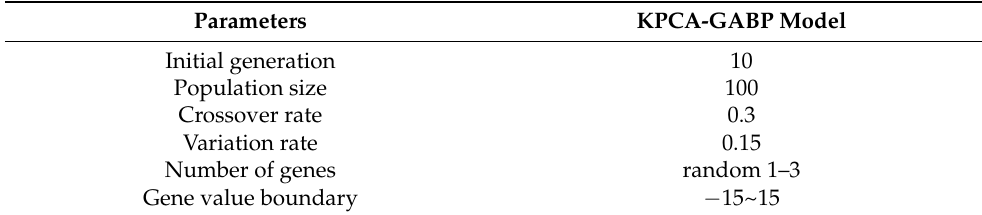
Table 3. Genetic algorithm optimization parameter settings.